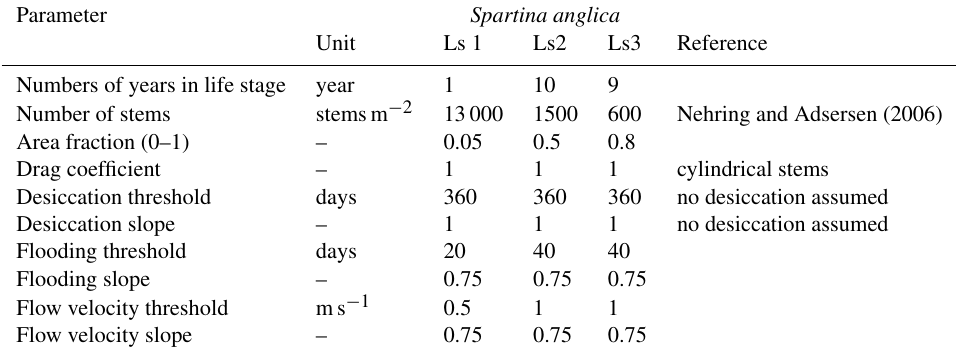
Table 3. Parameterisation of life-stage-specific characteristics of Spartina anglica